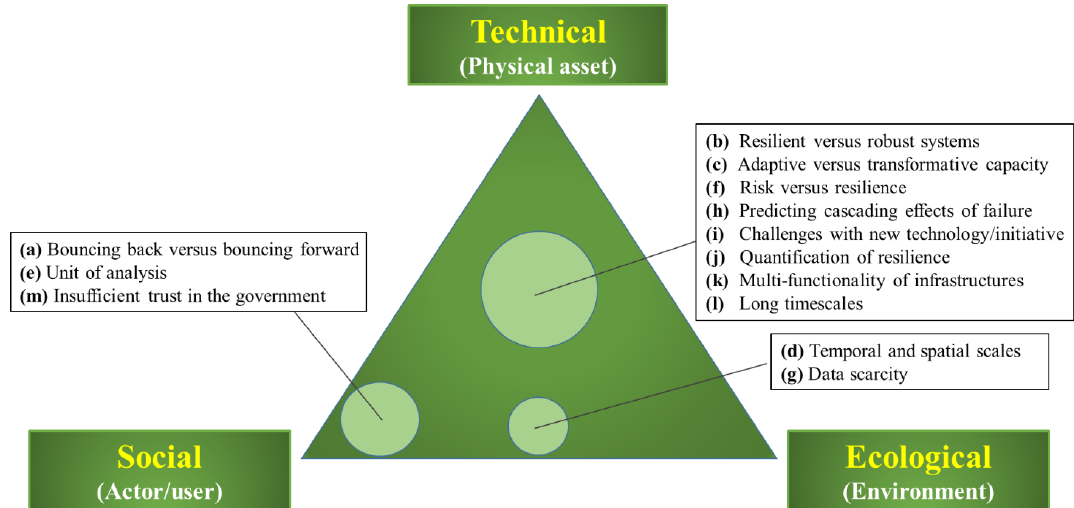
Figure 3. Conceptual and practical challenges in designing resilient vital infrastructures and their relevance to the system’s components.